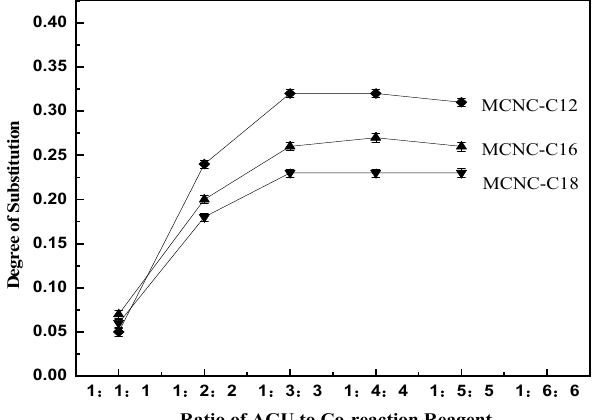
Figure 1. Effect of the ratio of co-reaction reagent on substitution degree of MCNC. (MCNC-C12: MCNC grafted with lauric acid; MCNC-C16: MCNC grafted with palmitic acid; MCNC-C18: MCNC grafted with stearic acid.)